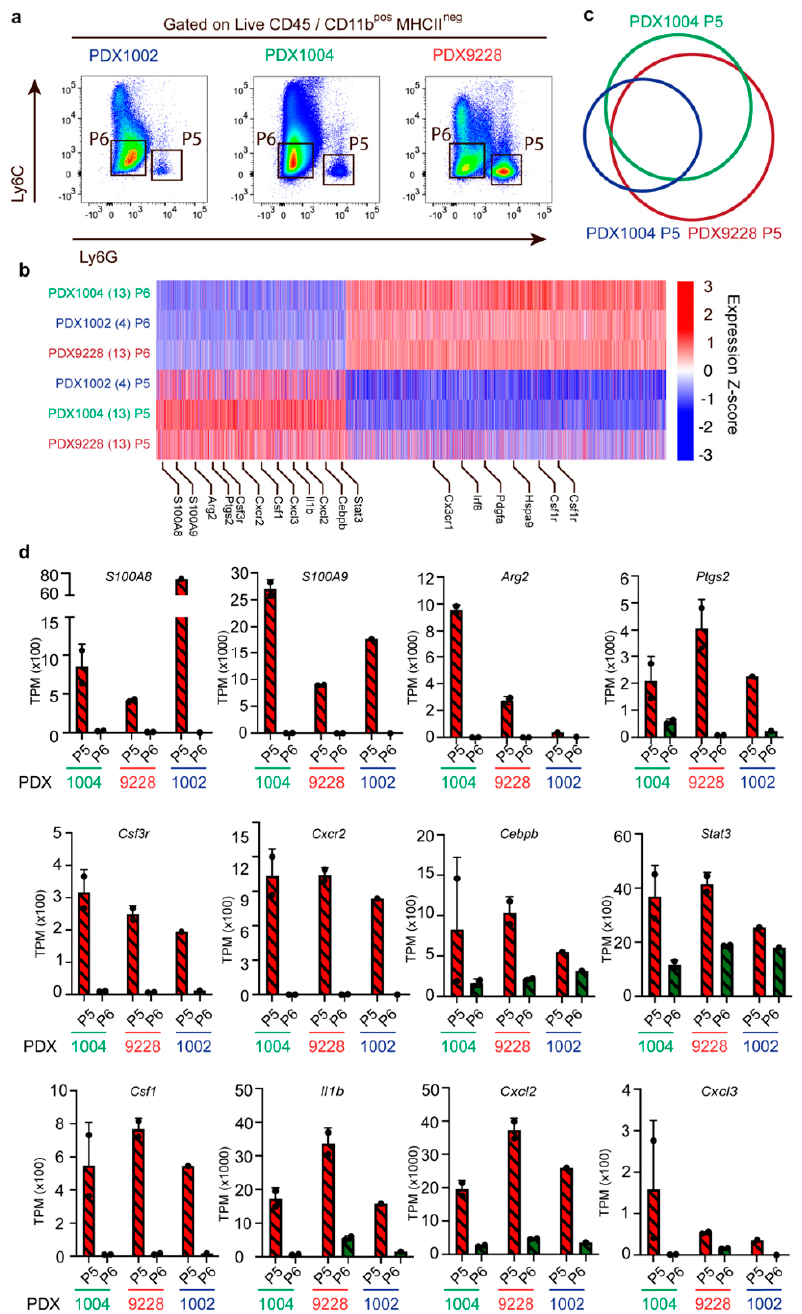
Figure 4. PMN-MDSC (CD11b + Ly6C − LyG6 + ) exhibit many molecular features related to immuno- suppression. Transcriptomic profiling of FACS-sorted PMN-MDSCs (P5) and non-MDSC (P6) cells in the PDX1002 (n = 1), PDX1004 (n = 2), and PDX9228 (n = 2) models. ( a ) Example of the sorting gates used for the isolation of PMN-MDSC (P5) (CD11b + Ly6C − LyG6 + ) and non-MDSC (P6) (CD11b pos Ly6C − LyG6 − ). ( b ) Heatmap of 6955 differentially expressed genes between the PMN- MDSC (P5) and non-MDSC (P6) populations in PDX1002, PDX1004, and PDX9228. Genes were considered differentially regulated when the FDR < 0.05 and the log2 fold change was > 1. ( c ) Venn diagram showing the overlap of genes with increased expression in the PMN-MDSC (P5) popula- tion between PDX1002, PDX1004, and PDX9228. ( d ) Expression of genes associated with molecular features related to PMN-MDSC immunosuppression in PMN-MDSC (P5) and non-MDSC (P6) in PDX9228 (n = 2), PDX1004 (n = 2), and PDX1002 (n = 1). The data are presented as the mean TPM. Each dot represents one sample. TPM: transcription per million. The PDX tumor size and timepoint upon harvest are shown in Supplementary Table S1.